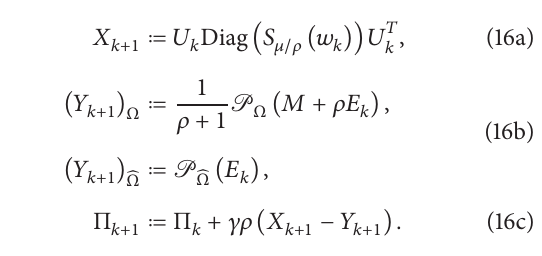
Algorithm 1: An exact ADMM-based algorithm of